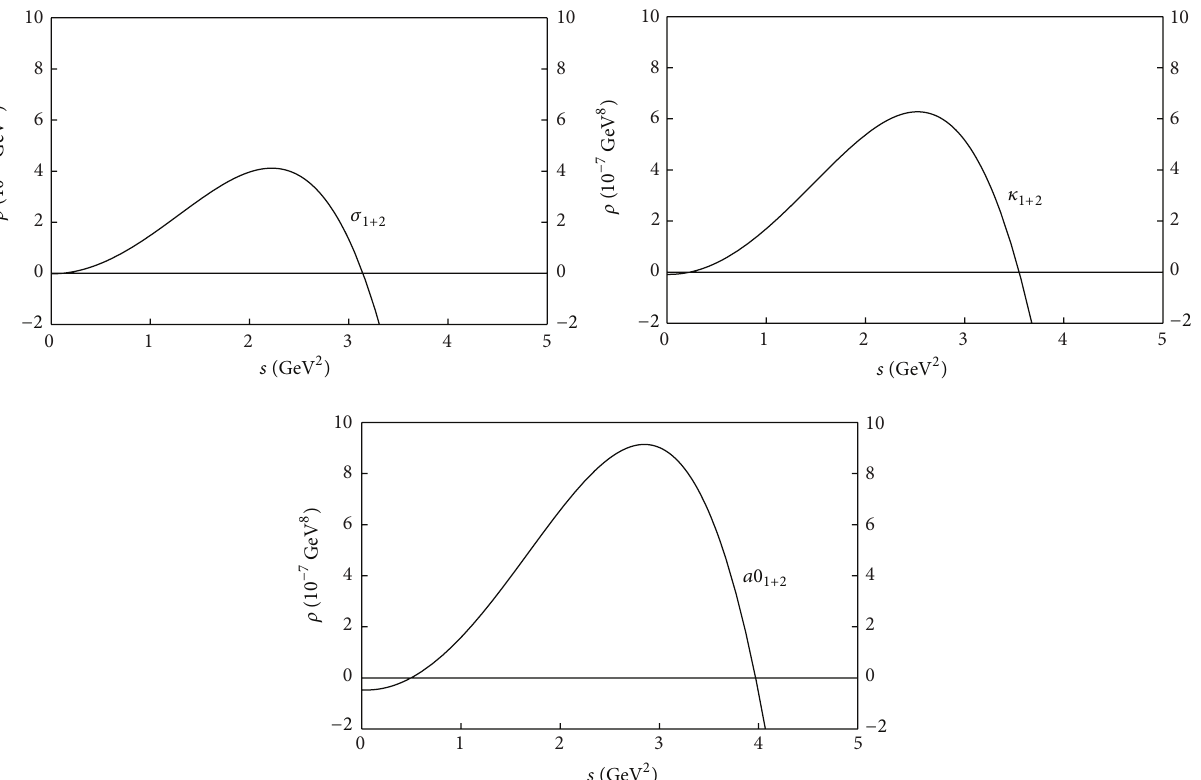
Figure6:Spectraldensitiesoflightscalarmesons 𝑓 0 (500) , 𝜅(800) ,and 𝑎 0 (980) ( 𝑓 0 (980) )asfunctionsoftheenergy 𝑠 ,whereonlytheconnected parts are taken into account.